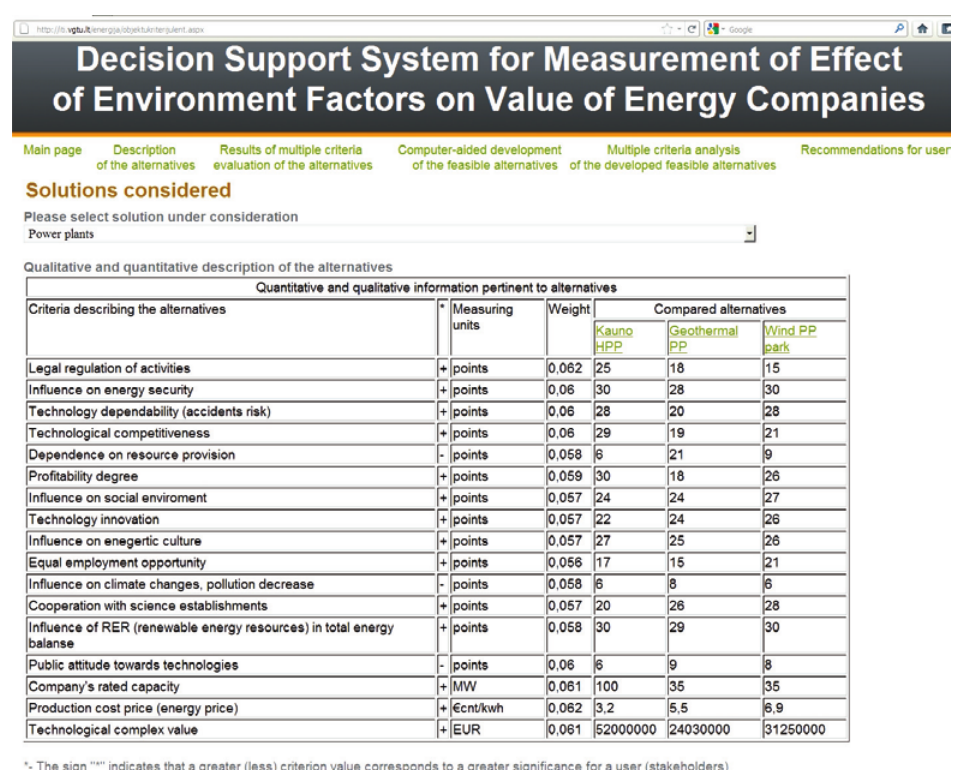
Figure 4. Display of the results of expert